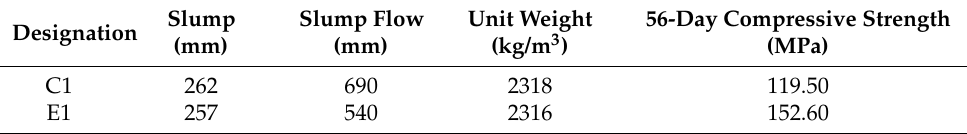
Table 7. The test results of the fresh properties and compressive strength of concrete.